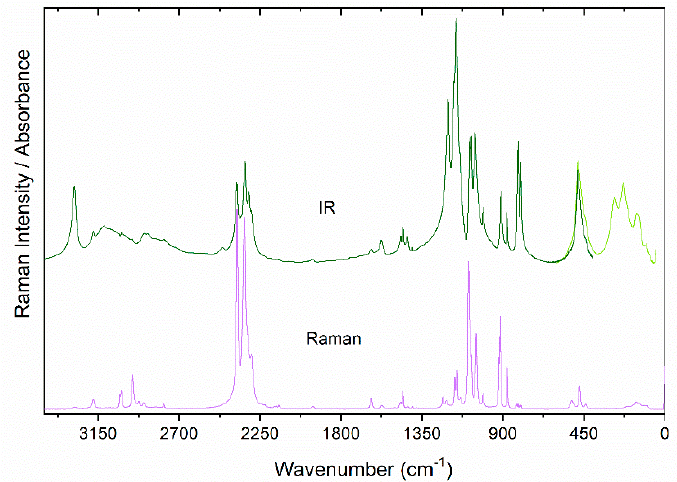
Figure 2. The polycrystalline IR and Raman spectra of the [MHy][Mn(H 2 POO) 3 ] perovskite measured at room temperature.